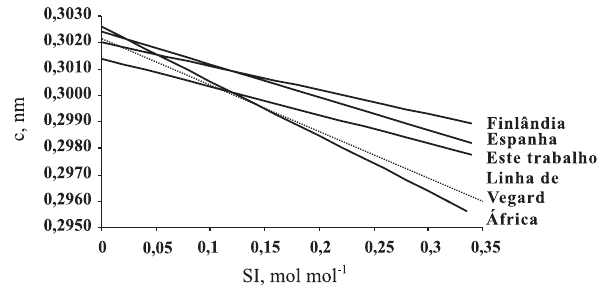
Figura 5. Comparação entre os valores do parâmetro “c” da célula unitária e substituição isomórfica de ferro por alumínio de goethita de doze amostras de solos de cor amarelada (ausência de hematita confirmada por DRX). A linha pontilhada representa a lei de Vegard, linha contínua e mais grossa, representa os resultados do presente